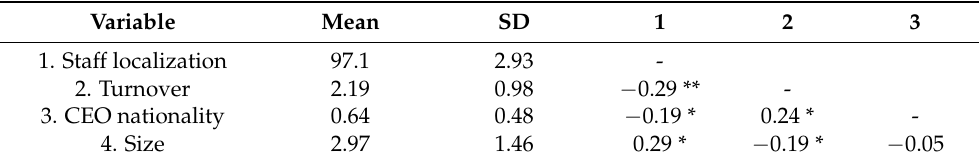
Table 2. Means, Standard Deviations, and Correlations.